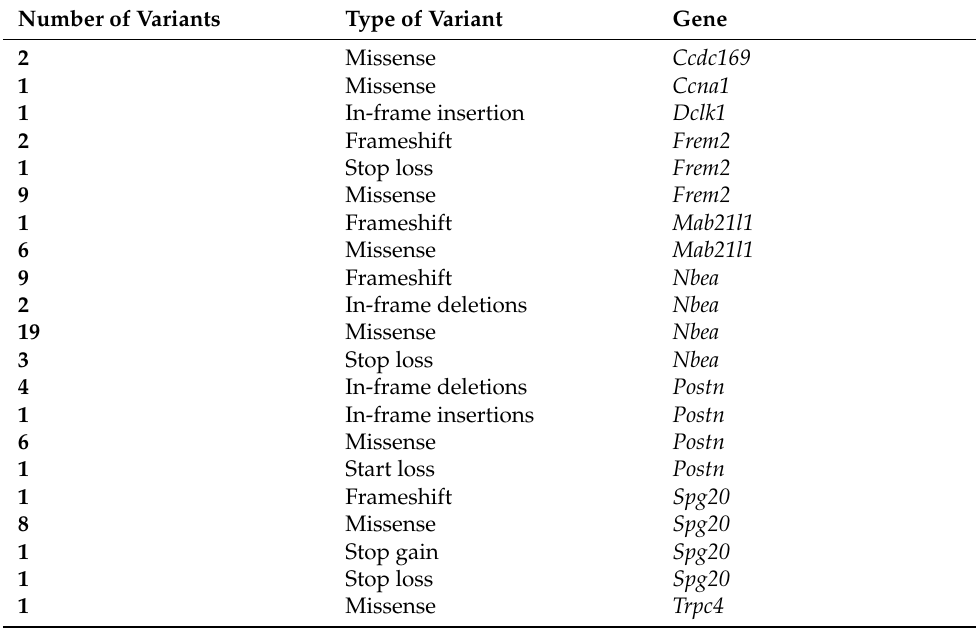
Table 2. QTL located at Chr3:53.667–54.942Mb for vertical activity contains predicted deleterious